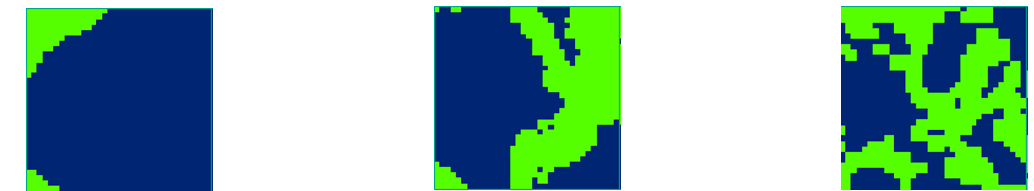
Figure 2. Thirty-meter resolution land cover maps of three 1-km resolution pixels with different degrees of fragmentation.